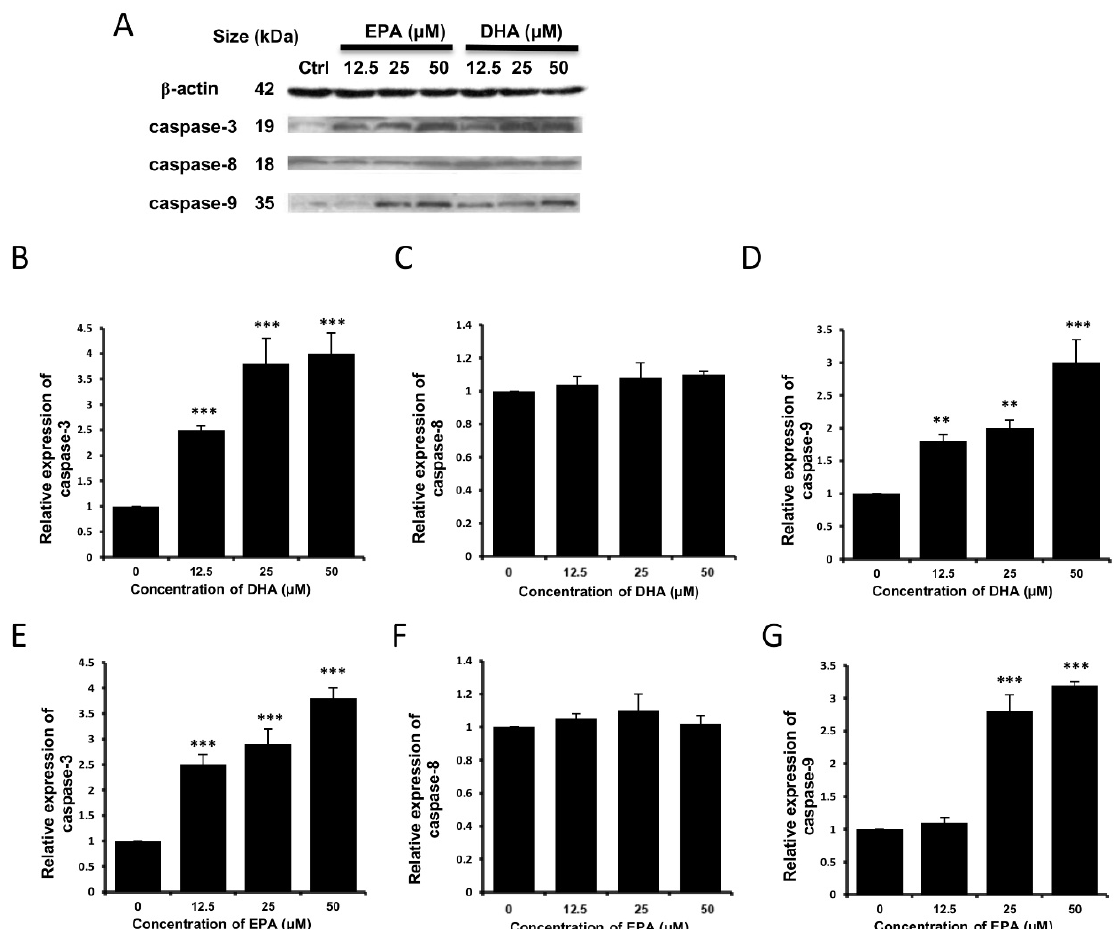
Figure 7. Effects of DHA and EPA on the expression levels of activated caspases in LA-N-1 cells. ( A ) LA-N-1 cells were incubated with various concentrations of EPA (Lanes 2, 3 and 4) or DHA (Lanes 5, 6 and 7) for 48 hours. Cells treated with ethanol (Lane 1) acted as the control. The protein expression levels of activated caspase-3, caspase-8 and caspase-9 were measured by Western blotting with β -actin serving as an internal control. The